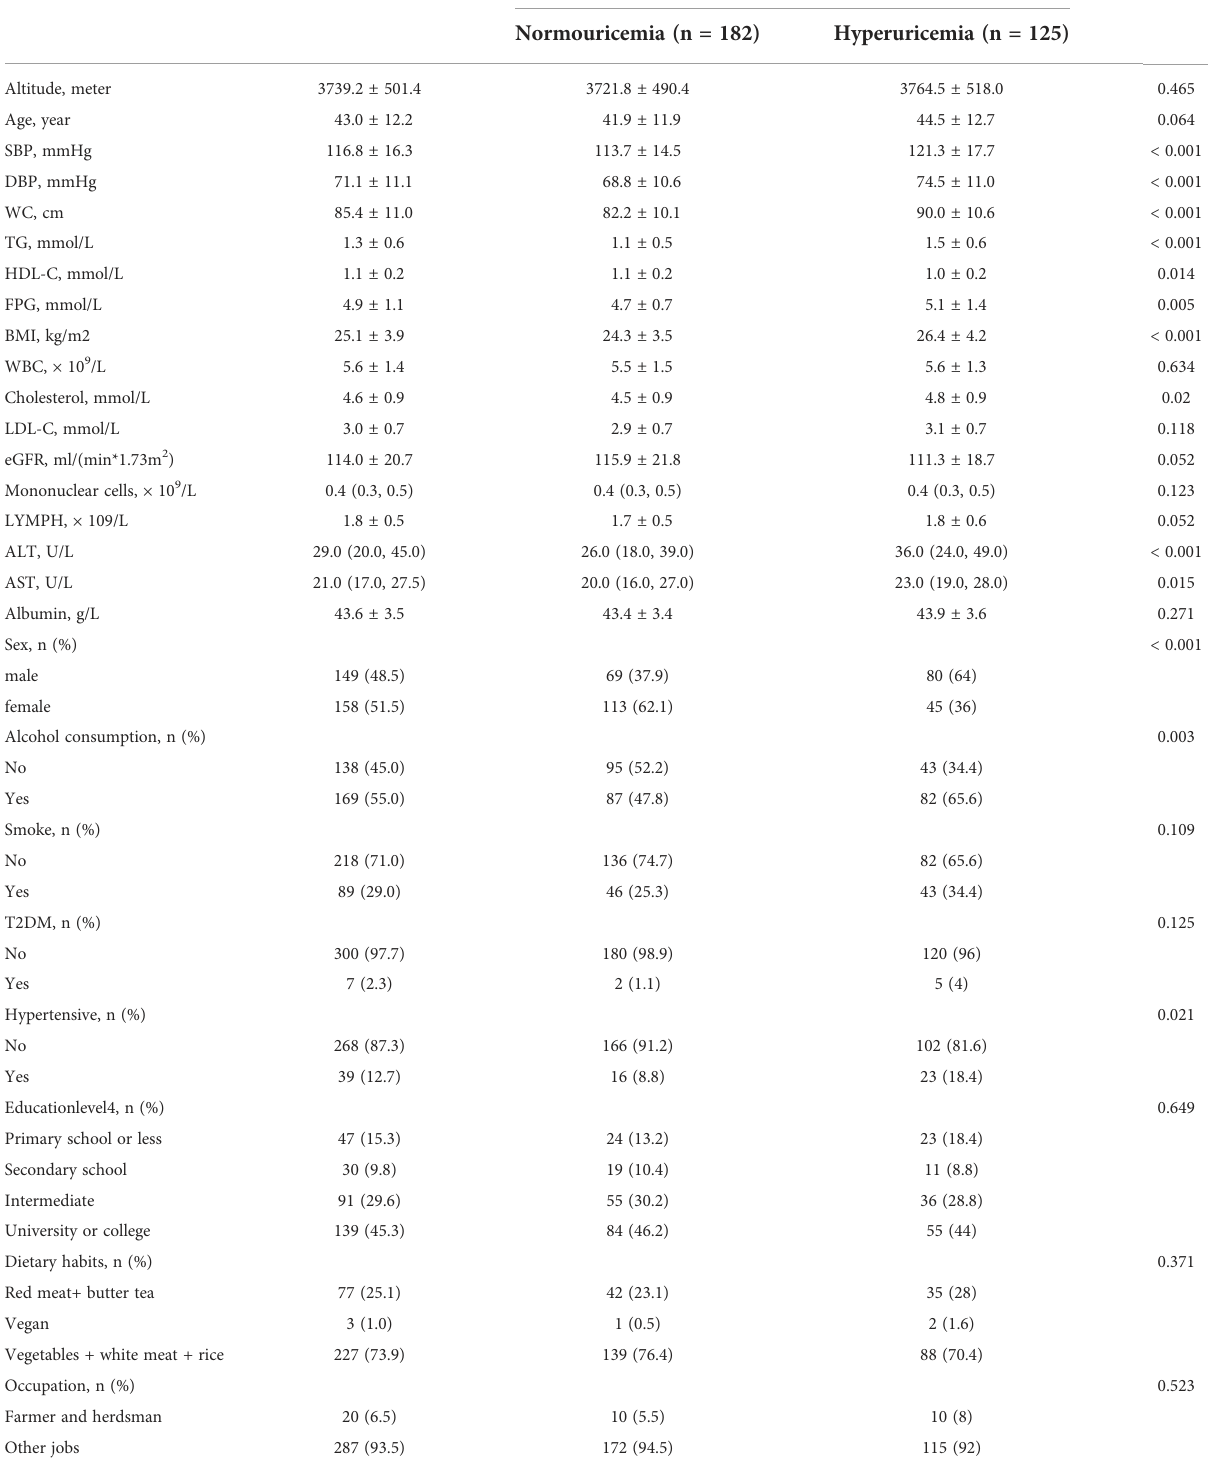
TABLE 1 Baseline characteristics of the study